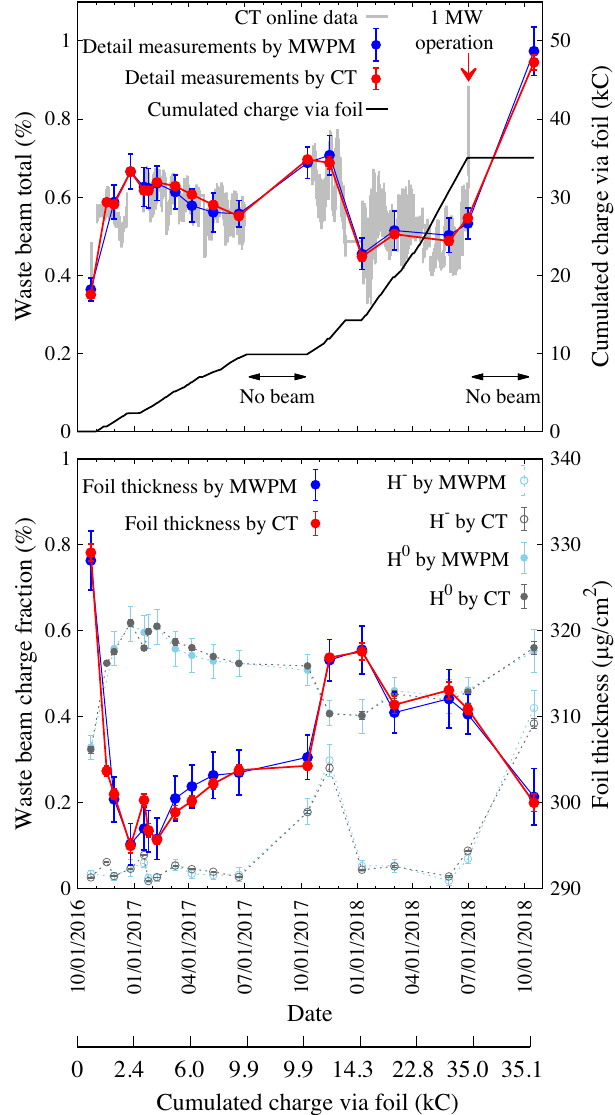
FIG. 12. (Top) Online measurement results of the total waste beam fraction obtained by the CT during RCS operation for nearly 2 yr. The individual measurement results obtained by using both CT and the MWPM are also plotted together. The cumu- lative charge via the foil is shown by the black curve plotted with respect to the right vertical axis. The charge fractions and the corresponding estimated effective foil thickness obtained from the detail measurements are shown in the figure at the